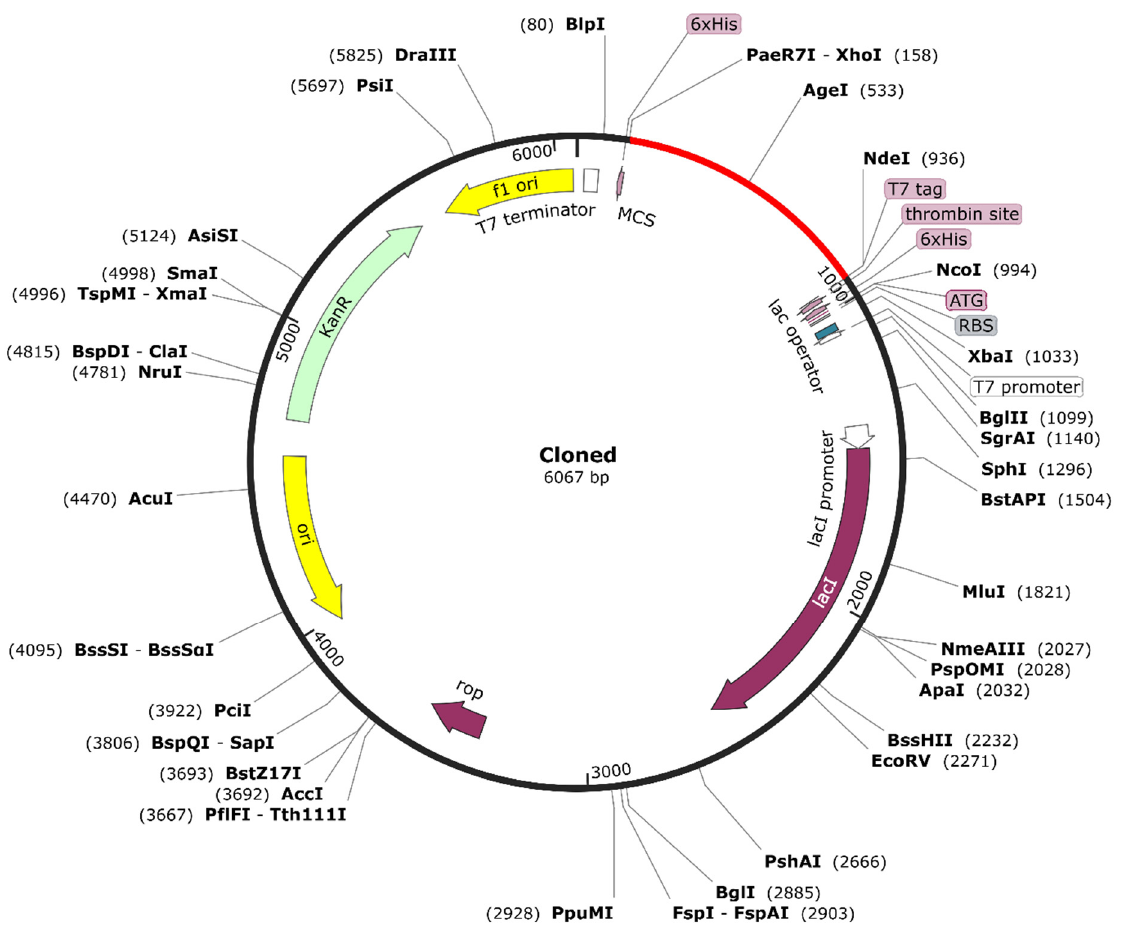
Figure 8. Simulated restriction cloning of the constructed multi-epitope vaccine. The multi-epitope vaccine construct’s codon-optimized sequence (shown in red color) was cloned in the pET-28a (+) expression vector (shown in black color) between the Xho I (158) and Nde I (936) restriction enzyme loci using SnapGene software. For efficient vaccine production, the designed construct can be expressed in E. coli (strain K12).